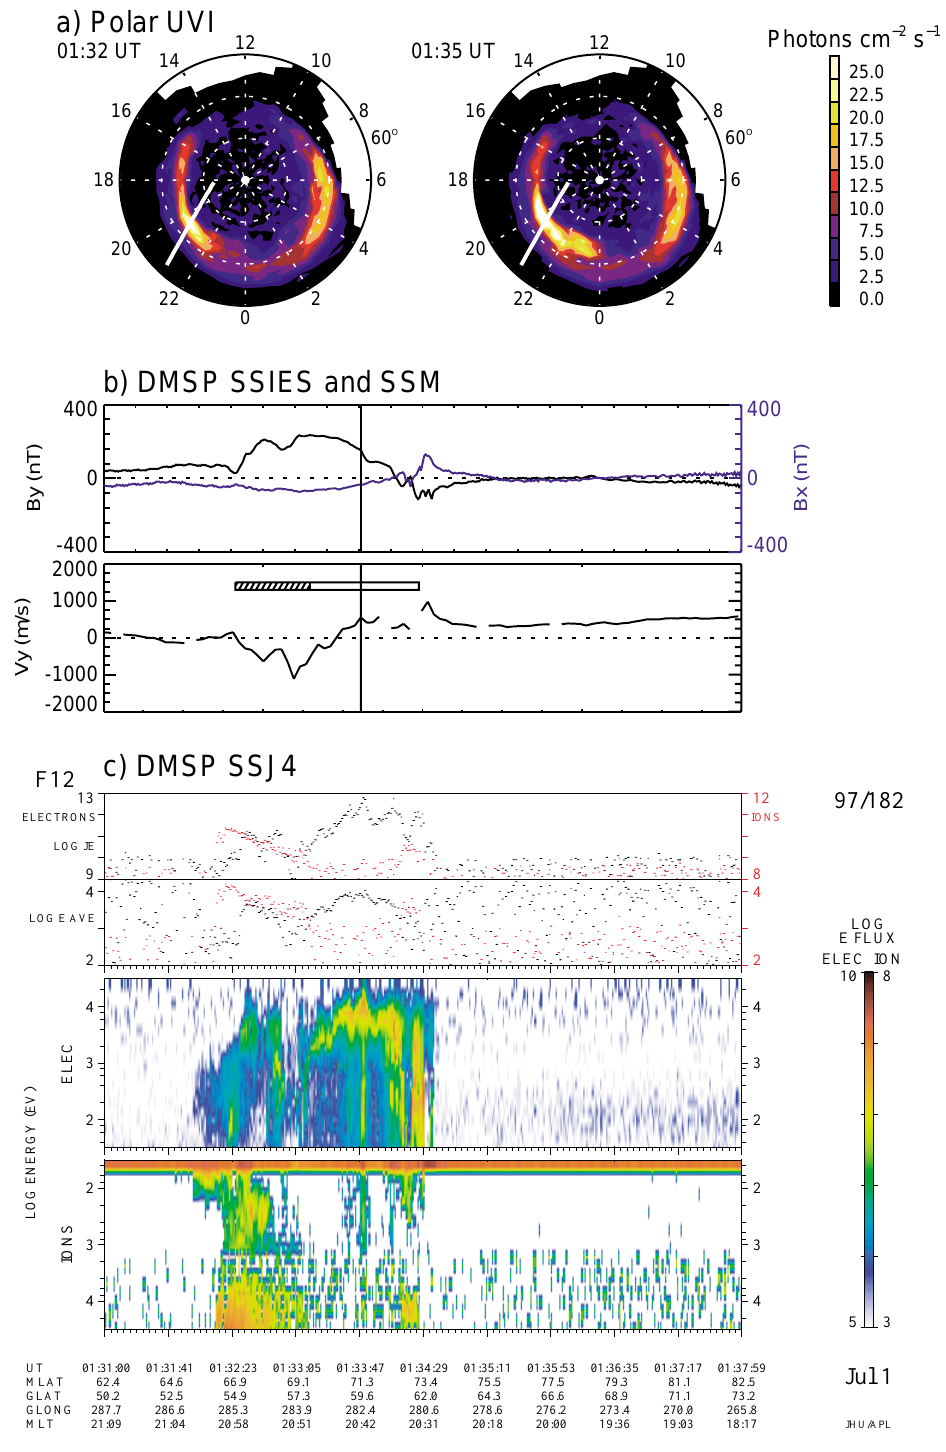
Fig. 3. A summary of observations for the 01:31–01:38 UT, 1 July 1997 event. The format is the same as that for Fig. 2.